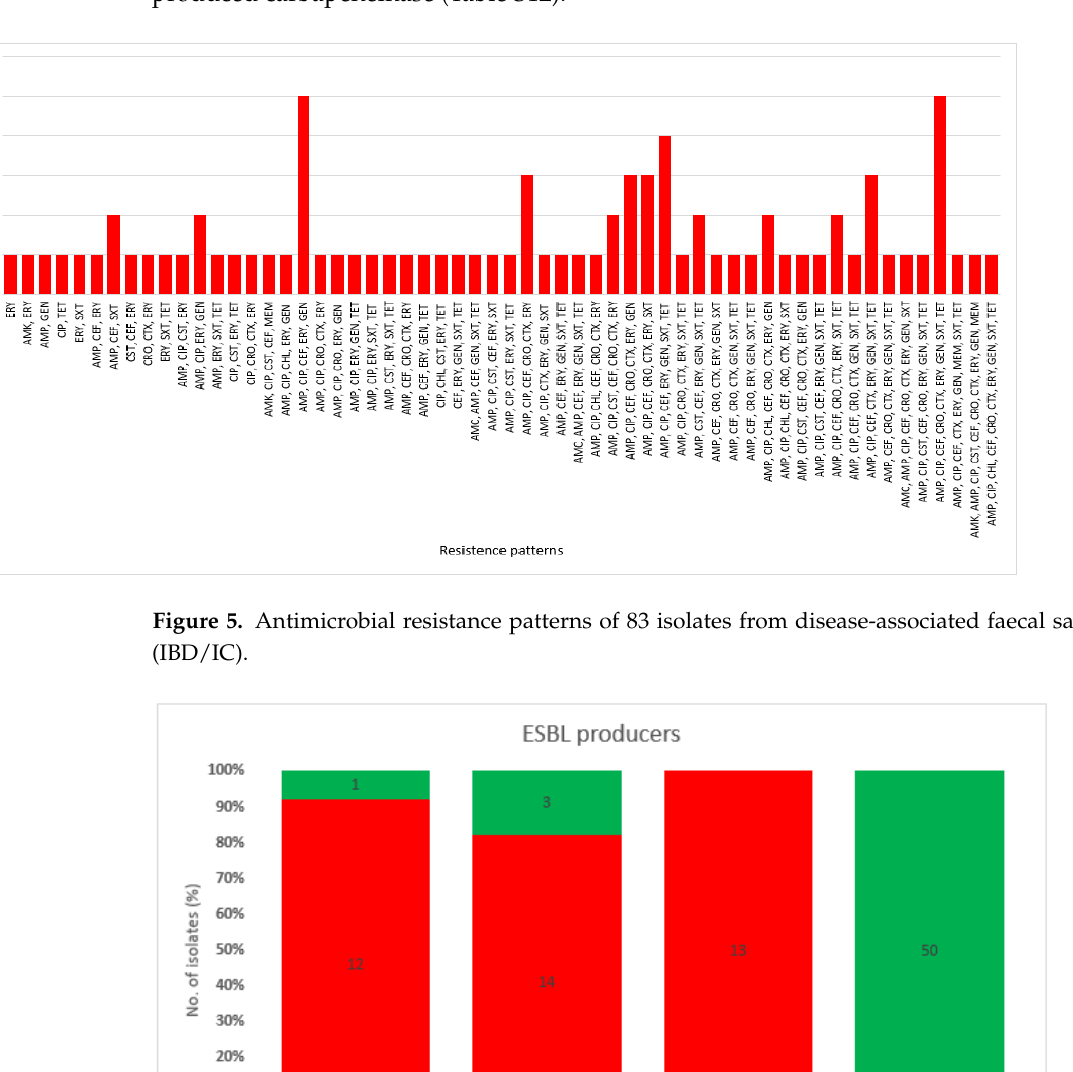
Figure 4. Antimicrobial susceptibility of 83 isolates from faecal samples of patients with CD, UC, and IC and 50 isolates from healthy controls. Number in the bar graph indicate the number of iso- lates.